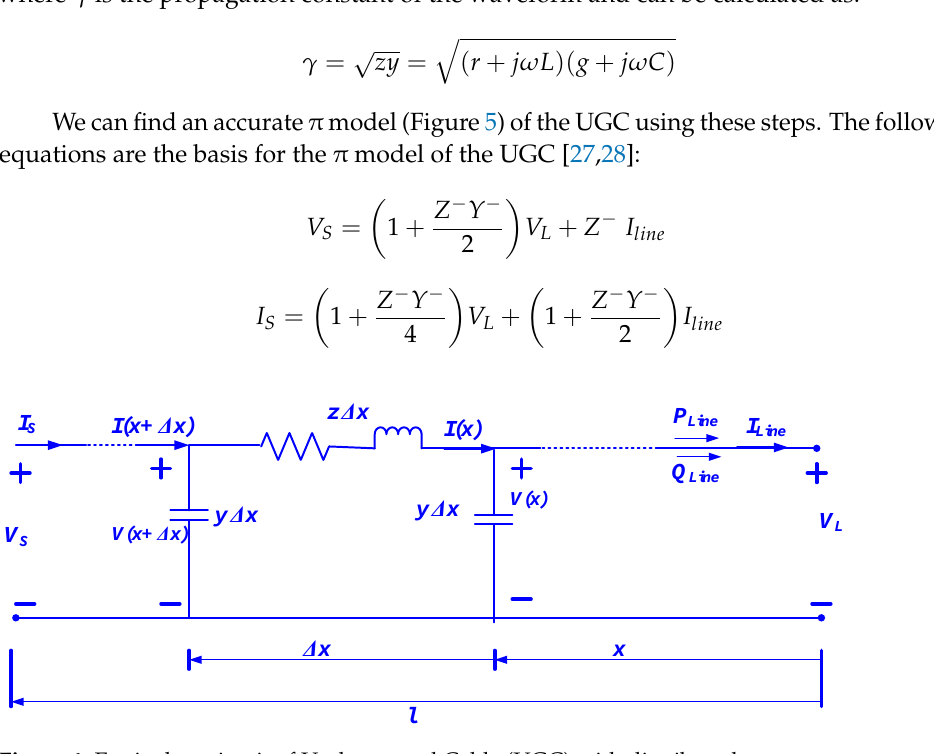
Figure 4. Equivalent circuit of Underground Cable (UGC) with distributed parameters.